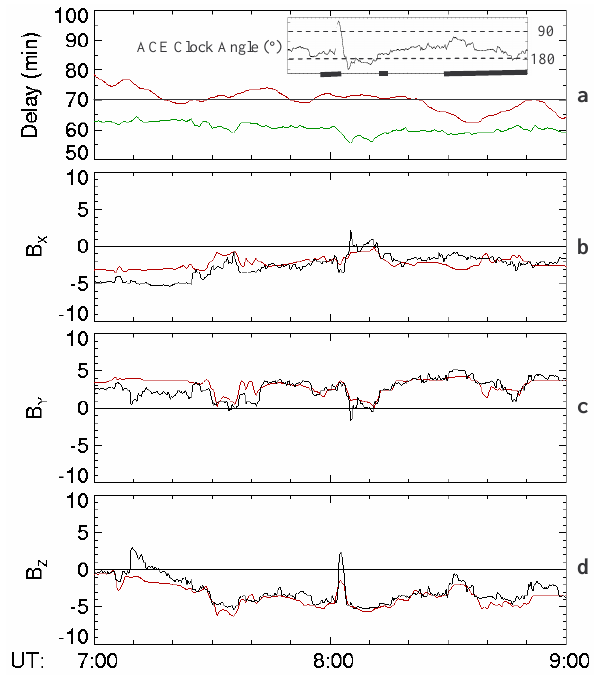
Fig. 1. Comparison of IMF data from ACE and magnetosheath data from Cluster to determine the applicable lag time between the satel- lites. ( a ) shows the advection delay (green) between ACE and Clus- ter calculated using the time-dependent ACE velocity. The vari- able lag using the technique of Weimer et al. (2002) is marked in red. ( b − d ) show three components of the IMF measured by ACE (black) for this interval. The corresponding Cluster magnetome- ter data, time adjusted according to the calculated variable lag, are overlaid in red. Because Cluster was located in the magnetosheath, the Cluster data have been multiplied by a factor of 0.27 to adjust for the increase in magnitude from passage through the bow shock. The insert in (a) shows the IMF clock angle at ACE for the period of interest. This clock angle plot is used in subsequent figures that compare the optical measurements with the IMF. The three intervals to be discussed are highlighted by the black